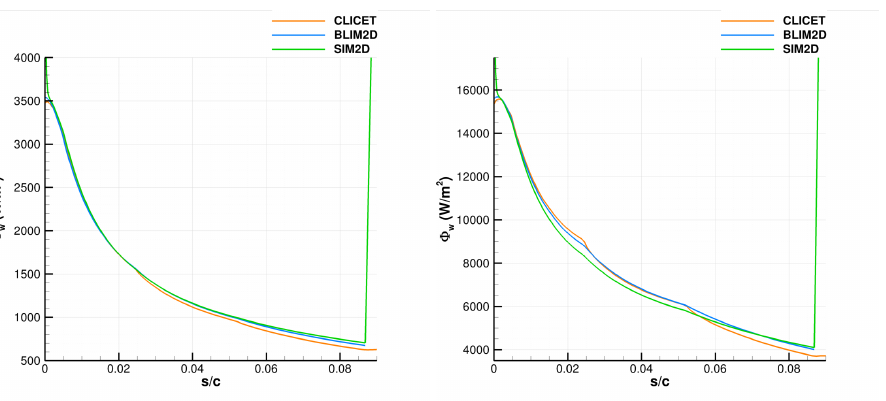
Figure 8. Wall heat flux produced by CLICET, BLIM2D, and SIM2D in the test cases of Table 1. ( Left ): RUN87b. ( Right ): RUN22a.